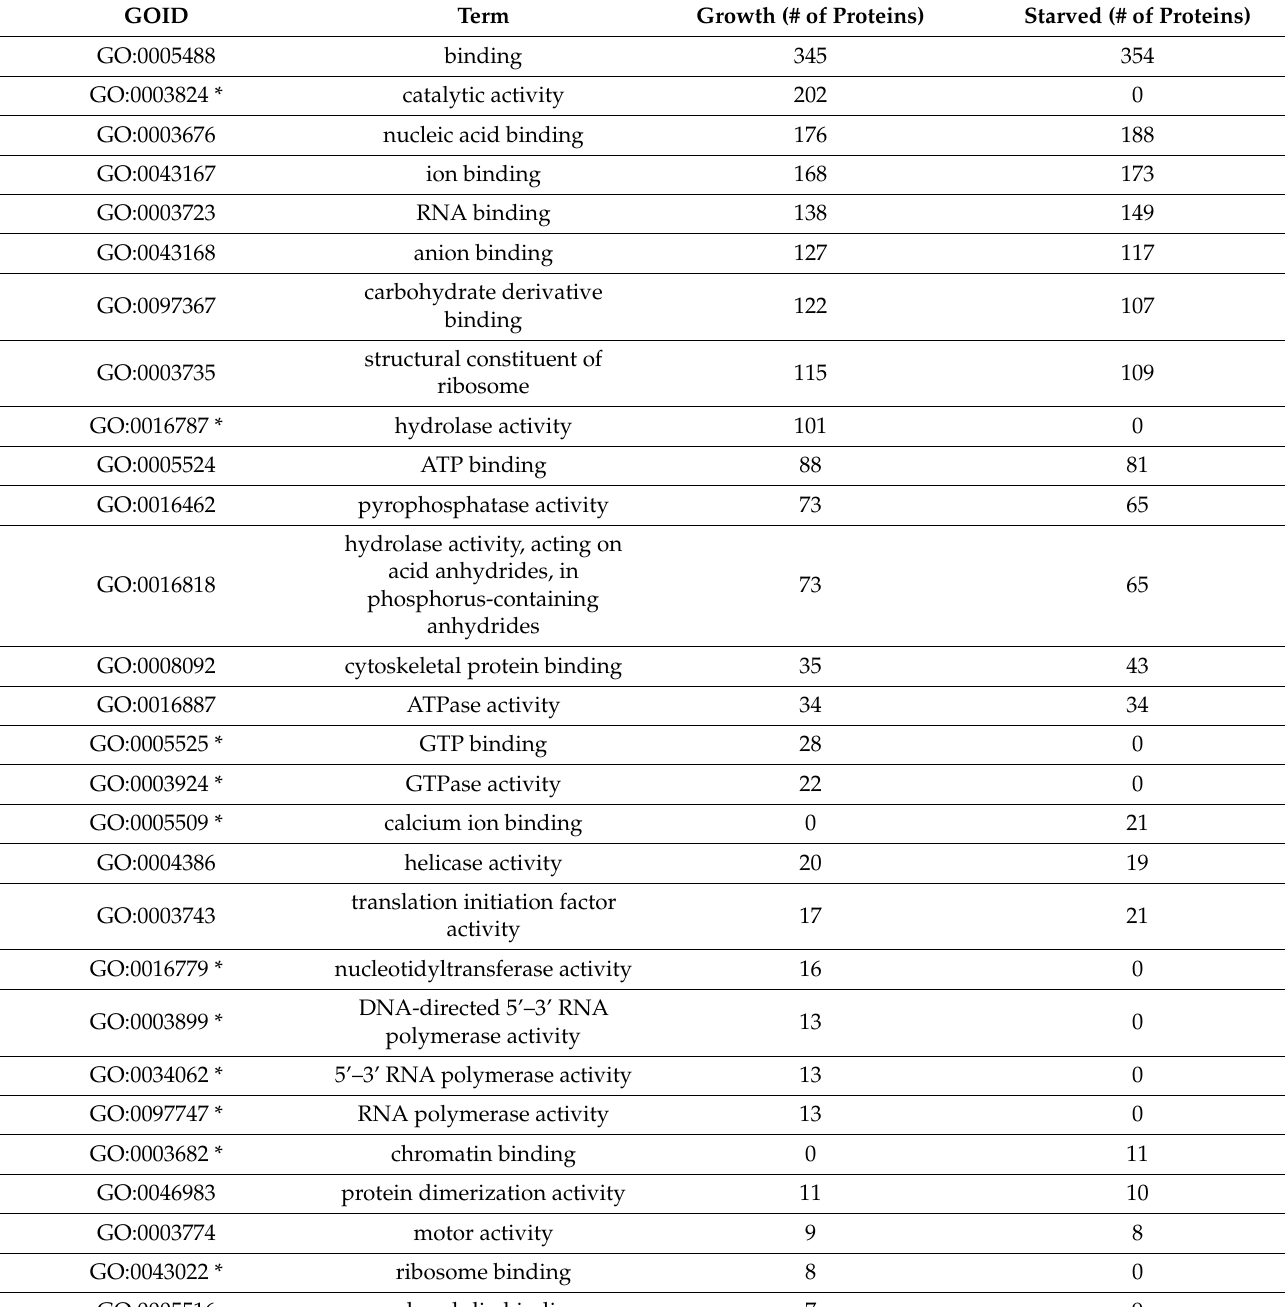
Table 4. Gene ontology (GO) term enrichment analysis summary (molecular function) for proteins identified in calmodulin (CaM) immunoprecipitation (IP) fractions. Displaying only those results with p < 0.05. GOID Growth (# of